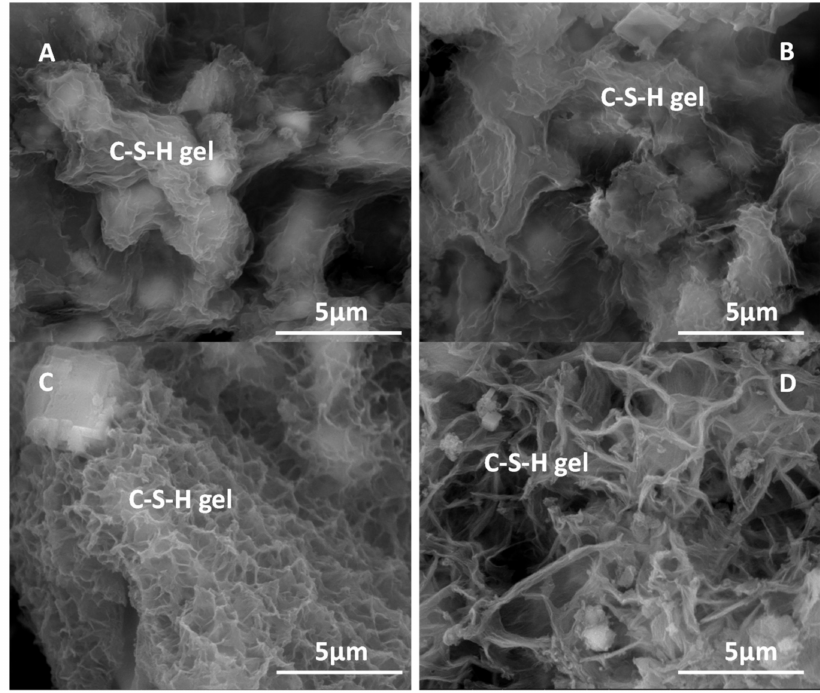
Figure 9. SEM/EDX analysis. ( A ) C–S–H gel in HsT/glass 2:1. ( B ) C–S–H gel in HcG/glass 1:1. ( C ) C–S–H gel in HsT/glass 1:2 at 90 days of reaction time. ( D ) C–S–H gel in HcG/glass 1:2 at 90 days of reaction time. All the figures have the same magnification, represented by the vector drawn in the